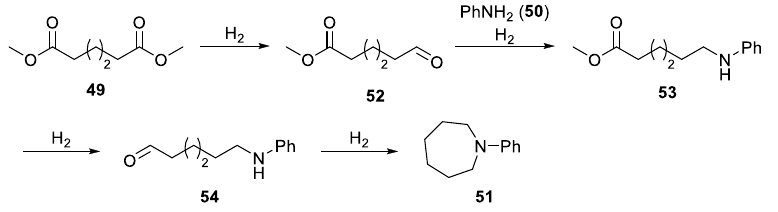
Scheme 12. Proposed reaction pathway for the hydrogenation of diester and reaction with aniline.